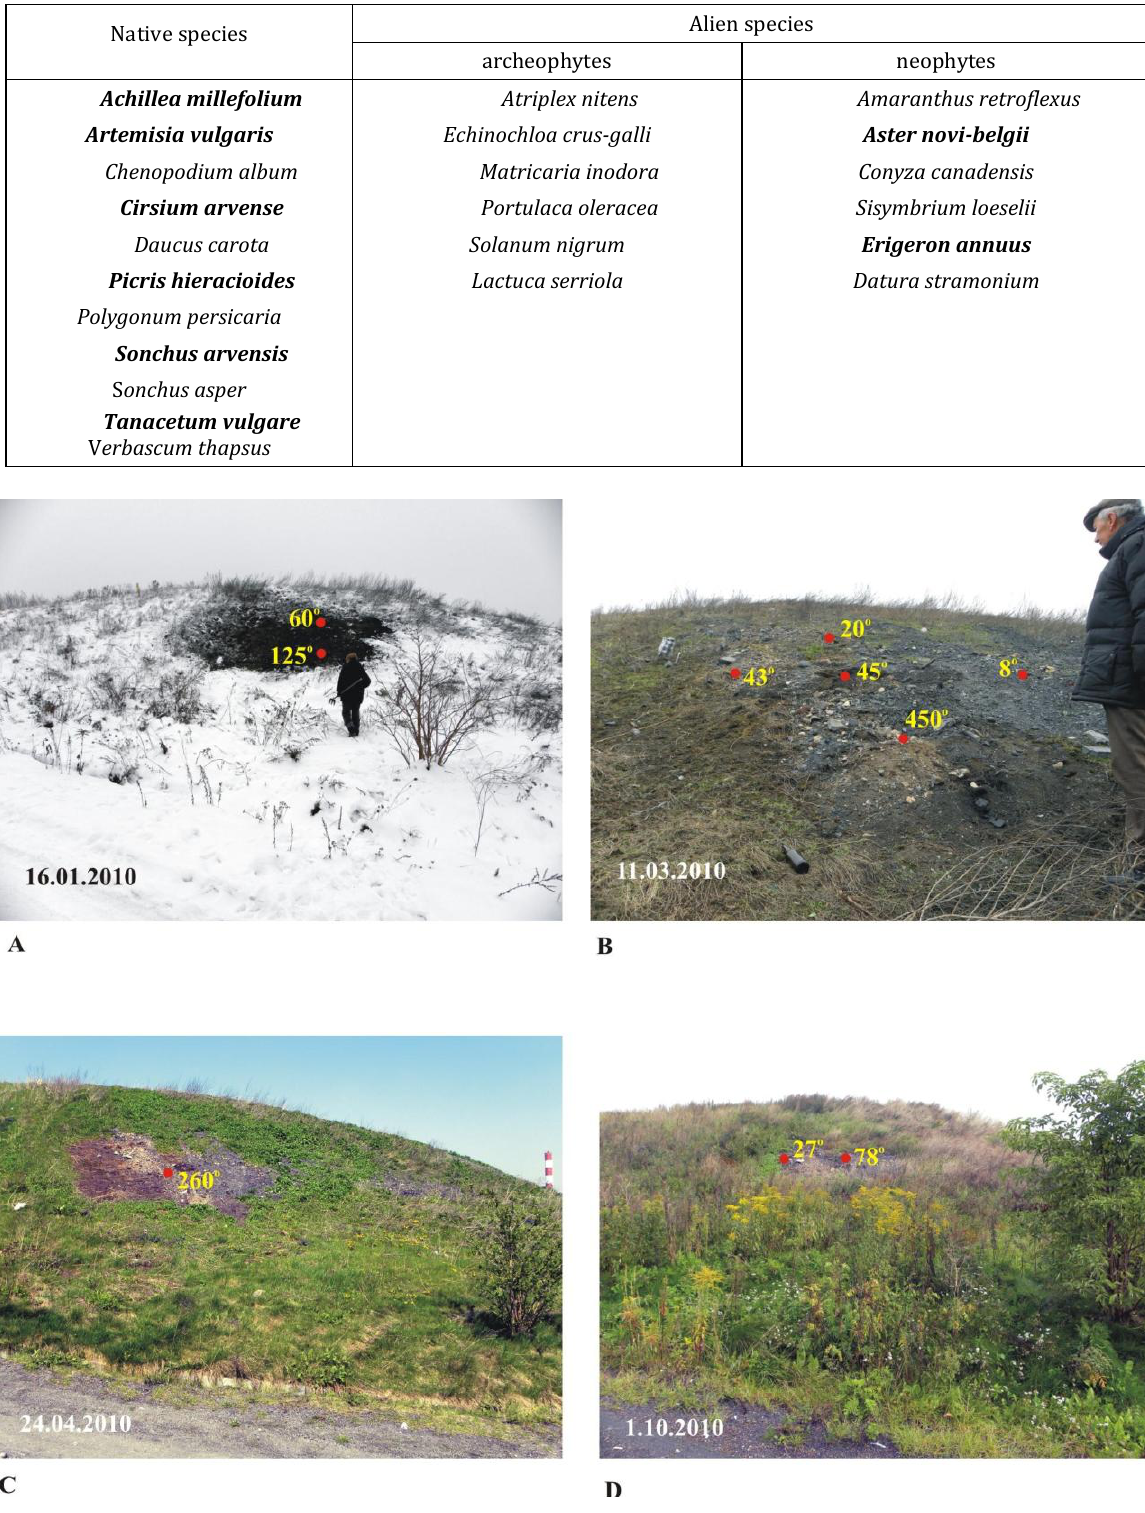
Fig. 2. Thermally active area on the southern slope of the Katowice-Wełnowiec dump in 2010. Temperature distribution measured 30 cm subsurface (J.